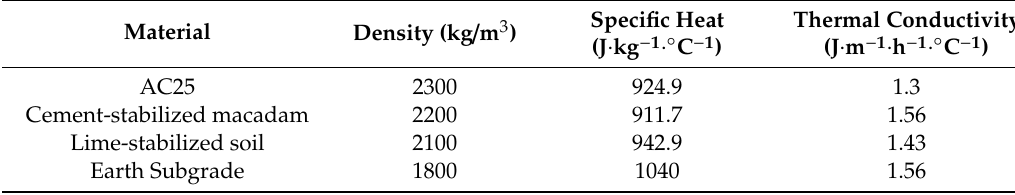
Table 5. Thermophysical property parameters of the